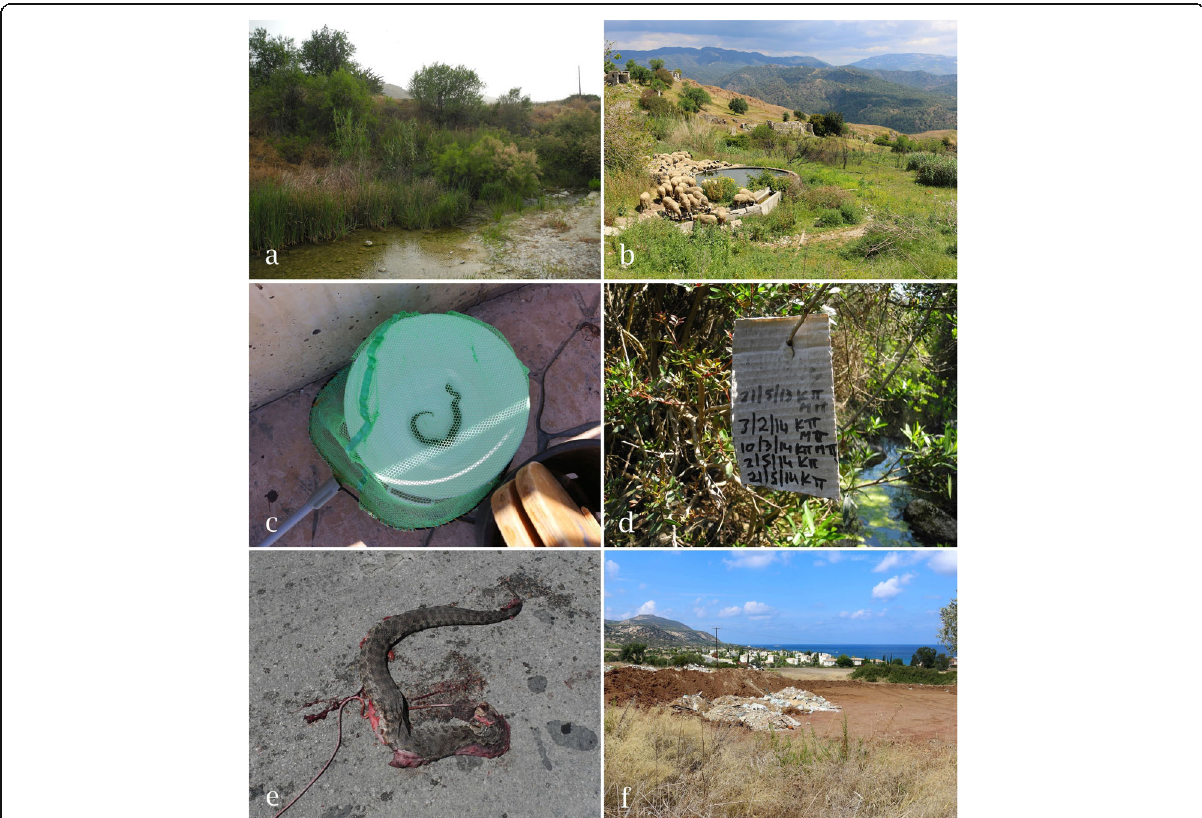
Fig. 3 a Richly structured stream bank with adjacent agricultural areas: habitat of the blunt-nosed viper. b Rocky slopes with shrubs and ruins: blunt-nosed viper habitat used for sheep and goat grazing. c Juvenile blunt-nosed viper caught by children at noon (12:40 PM) in a residential swimming pool in central Paphos district (13 September 2015). e Signatures of mosquito control workers at a stream show that this riparian area – habitat of M. l. lebetina – is regularly visited by people. e Blunt-nosed viper killed and dragged on the road with a string attached to the snake ’ s neck (14 April 2014). f Destruction of wild blunt-nosed viper habitat for real-estate development on Akamas Peninsula (1 October 2017). Loss of pristine habitats is a common problem in coastal areas of Cyprus. Photos: D.